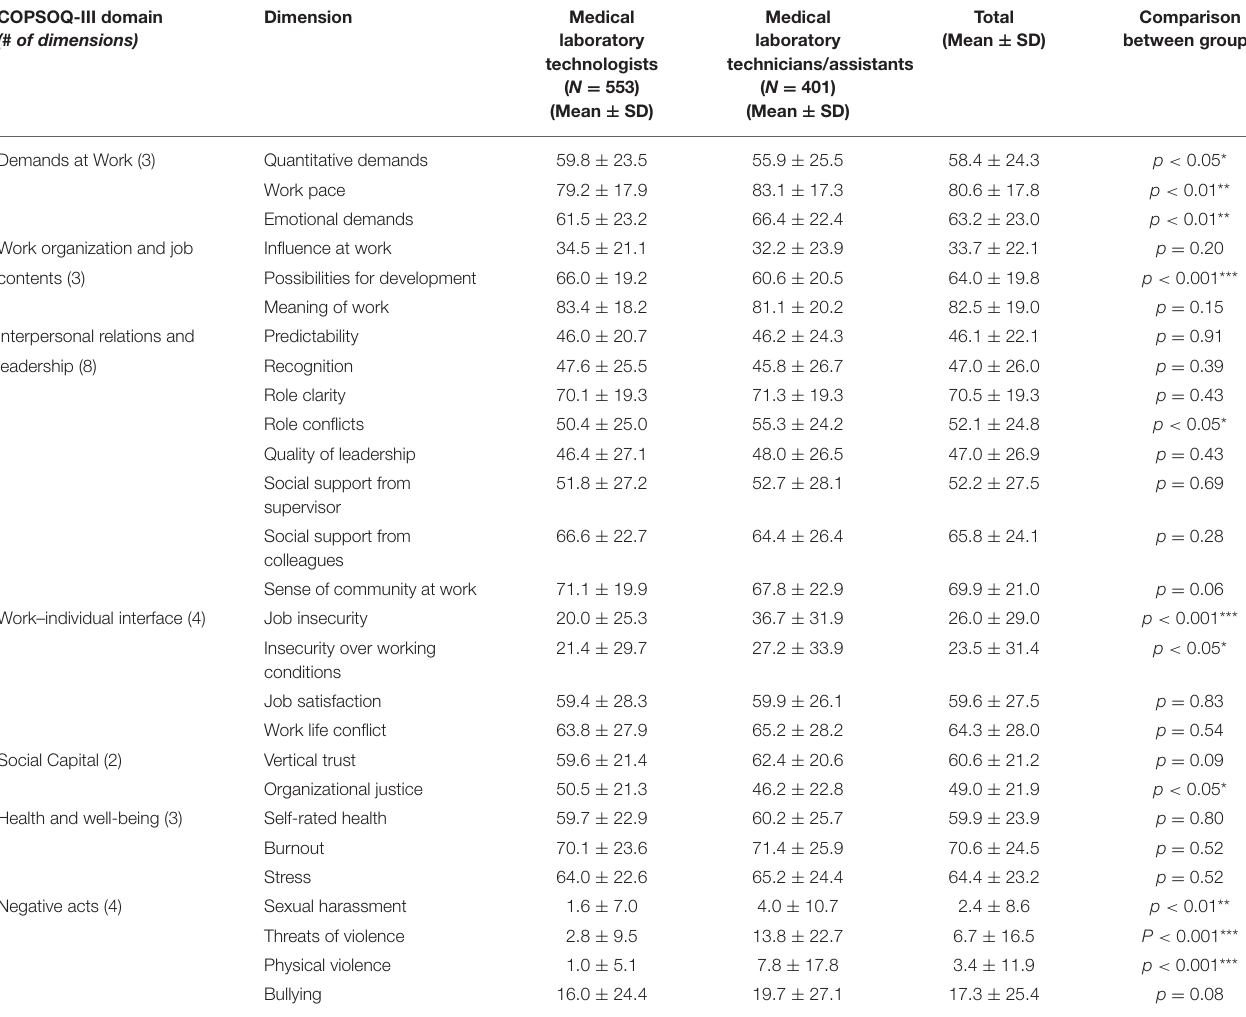
TABLE 2 | A comparison of psychosocial factors of the respondents based on COPSOQ-III dimensions. COPSOQ-III domain (# of